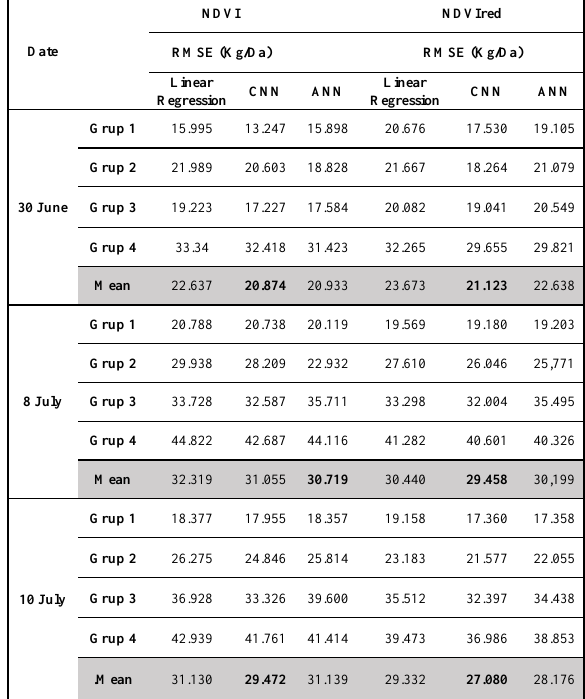
Table 2. RMSE results obtained from the methods and indices.